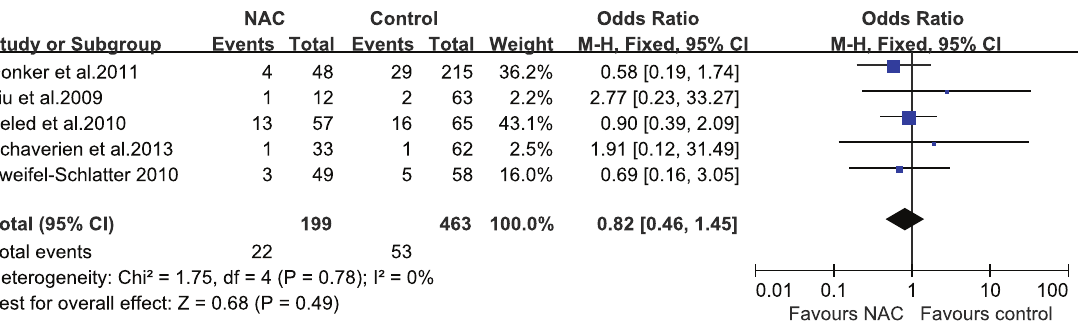
Figure 6. Pooled results of reoperations in patients treated with NAC. The size of the solid squares is inversely proportional to the variance of the study estimate. The diamond represents the fixed effects odds ratio and 95% confidence